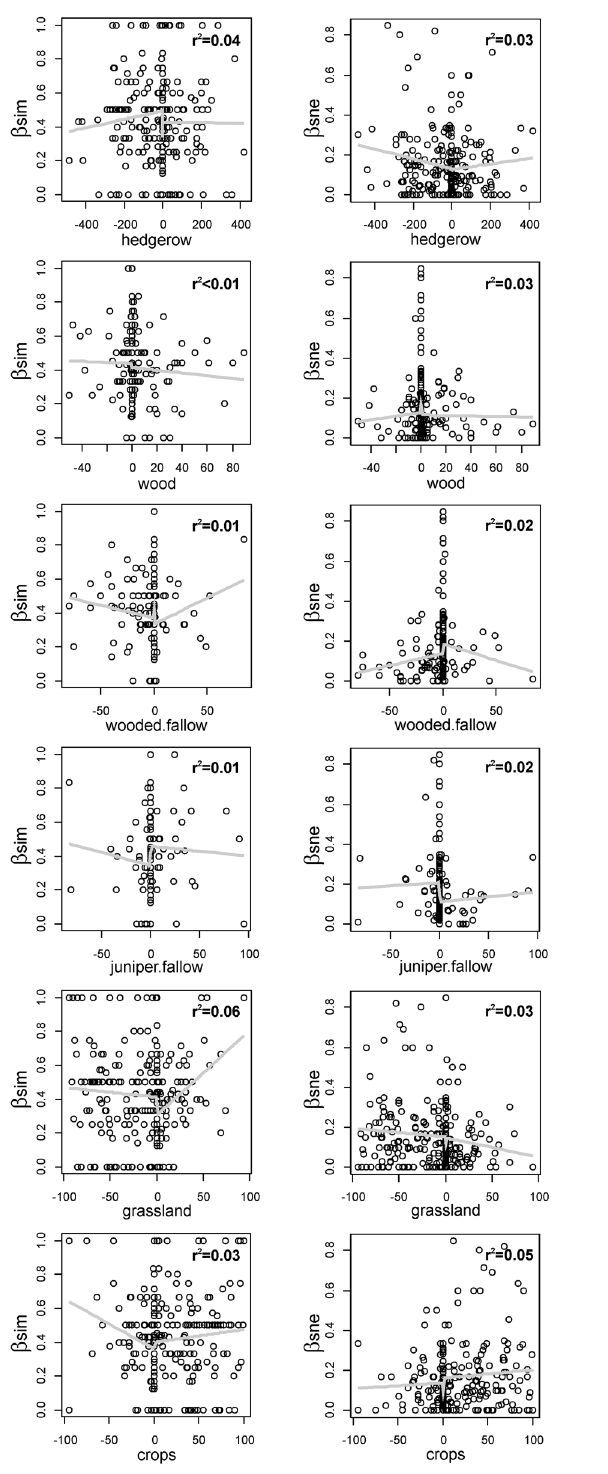
Fig 1. Relationship between temporal dissimilarity (turnover and nestedness-resultant components in the left and right column, respectively) and land cover change (by rows: temporal variation in hedgerow length, percentage of woodland area, wooded fallow area, juniper fallow area, permanent grassland area, crop area). Gray lines are the fitted functions from which r 2 values were computed.